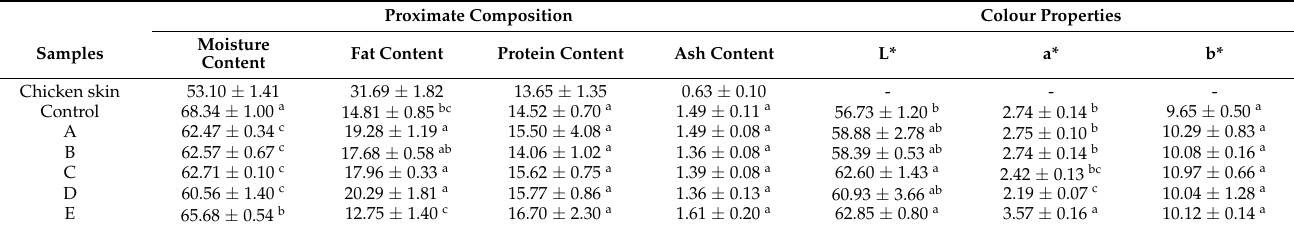
Table 4. The proximate composition and colour properties of the fat-replaced samples with palm shortenings (PS) of various melting ranges (MR) as compared to the control sample with chicken skin. Proximate Composition Colour